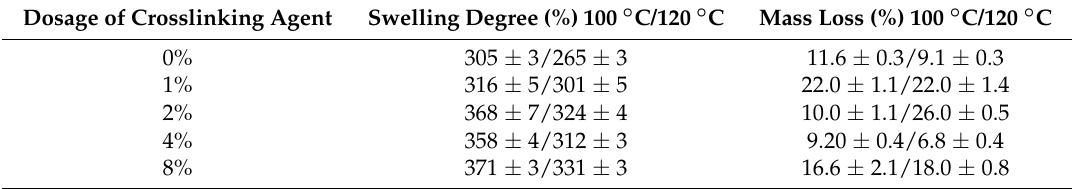
Table 2. Alkali resistance results of composite membranes (after heating at 100 ◦ C and 120 ◦ C,